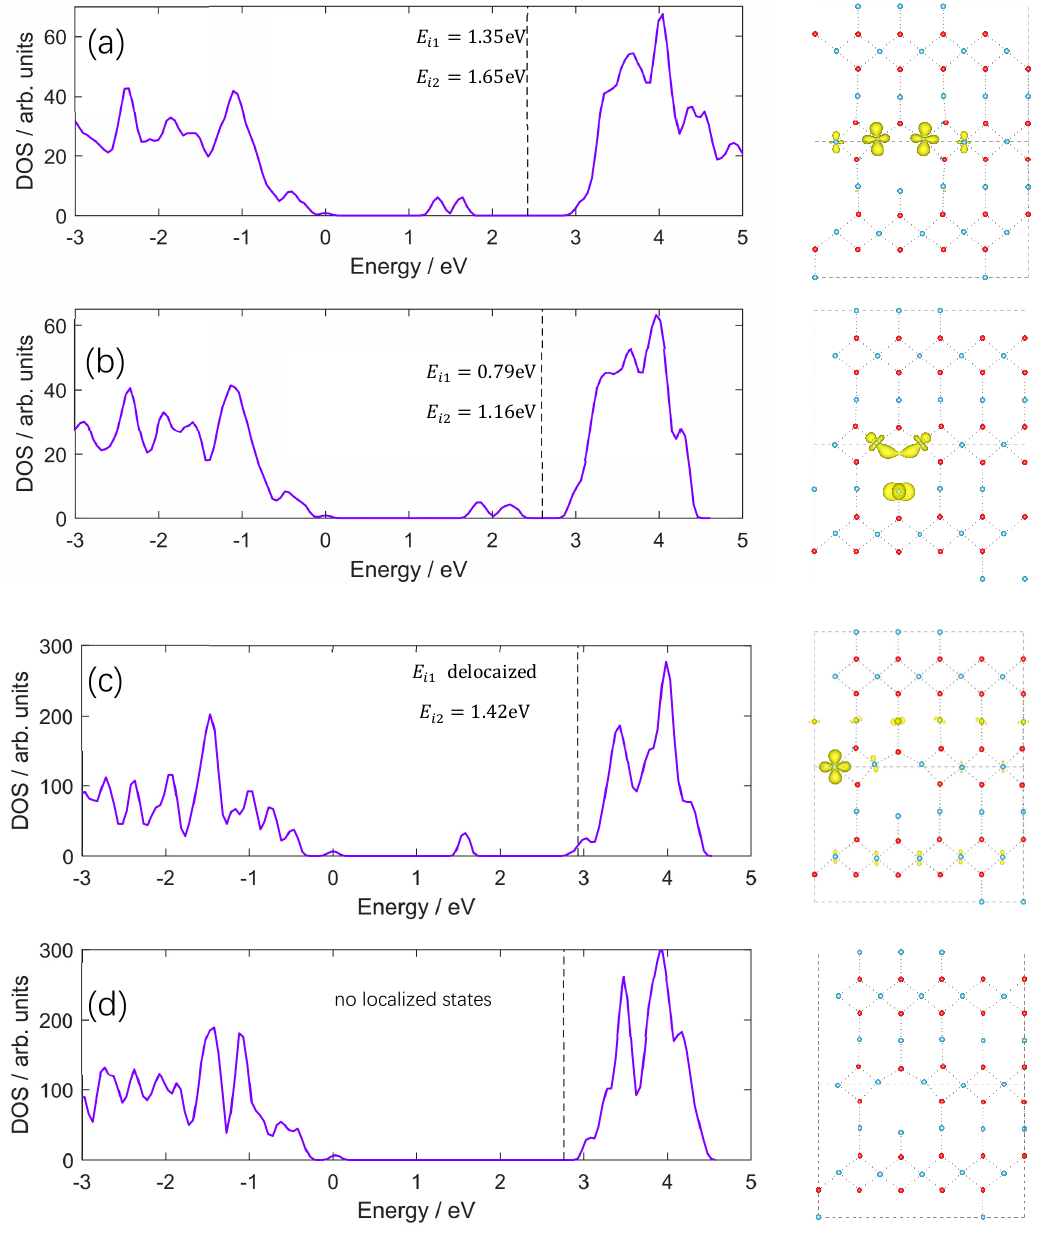
Figure 2. Density of state (DOS) of polaronic configurations of 3 × 3 × 5 supercell and corresponding atomic structures of VO-(110) plane. The vertical dashed line denotes the Fermi level, E i 1 and E i 2 represent the relative energy of polaronic states and conduction band minimum. Subgraph ( a ) is small polaronic configuration of two electrons are each localized at single Ti site forming two small polarons. ( b ) is mixed configuration of one of the two electrons are shared by two equatorial Ti atoms forming a hybrid state (also called large polaronic state [48]) and the other is localized at apical Ti as small polaron. This configuration is called mixed configuration in the following text. ( c ) is partly delocalized configuration of one electron is trapped at Ti as a small polaron with only one localized state in the bandgap. The other electron is delocalized and the Fermi level moves up into the bottom of conduction band. ( d ) Singlet state with no net spin and localized states in the bandgap. Yellow lobes on Ti atoms correspond to net spin with density iso-surface of 0.01 e · A − 3 . All the solutions are sorted by total energy and labeled in alphabetical order.